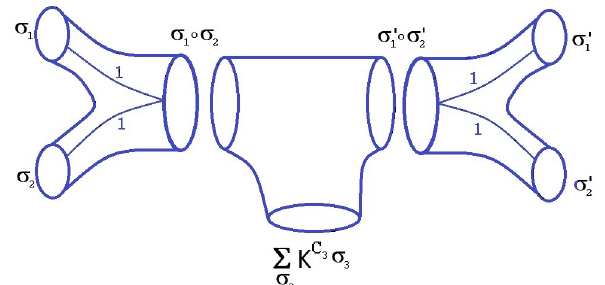
Figure 2 . The interpretation of the inner product (6.40) in terms of diagrams. Here σ 1 = (1 , 2 , · · · , h 1) , σ = ( h +1 , · · · , h 2) and σ = (1 , 2 , · · · , h 1)( h +1 , · · · , h 2) . 1 − 2 1 , h 1 2 − 1 ◦ σ 2 1 − 1 , h 1 2 − There are similar formulas for the primed permutations. The unit defect ensures that σ is a 1 ◦ σ 2 specific permutation and not a sum over a conjugacy class. C is the number of cycles in σ and 3 3 σ ◦ ψ is the outer products of permutations σ and ψ .